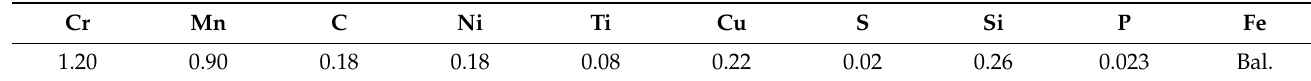
Table 3. Chemical composition of SCM 420 (wt. %).